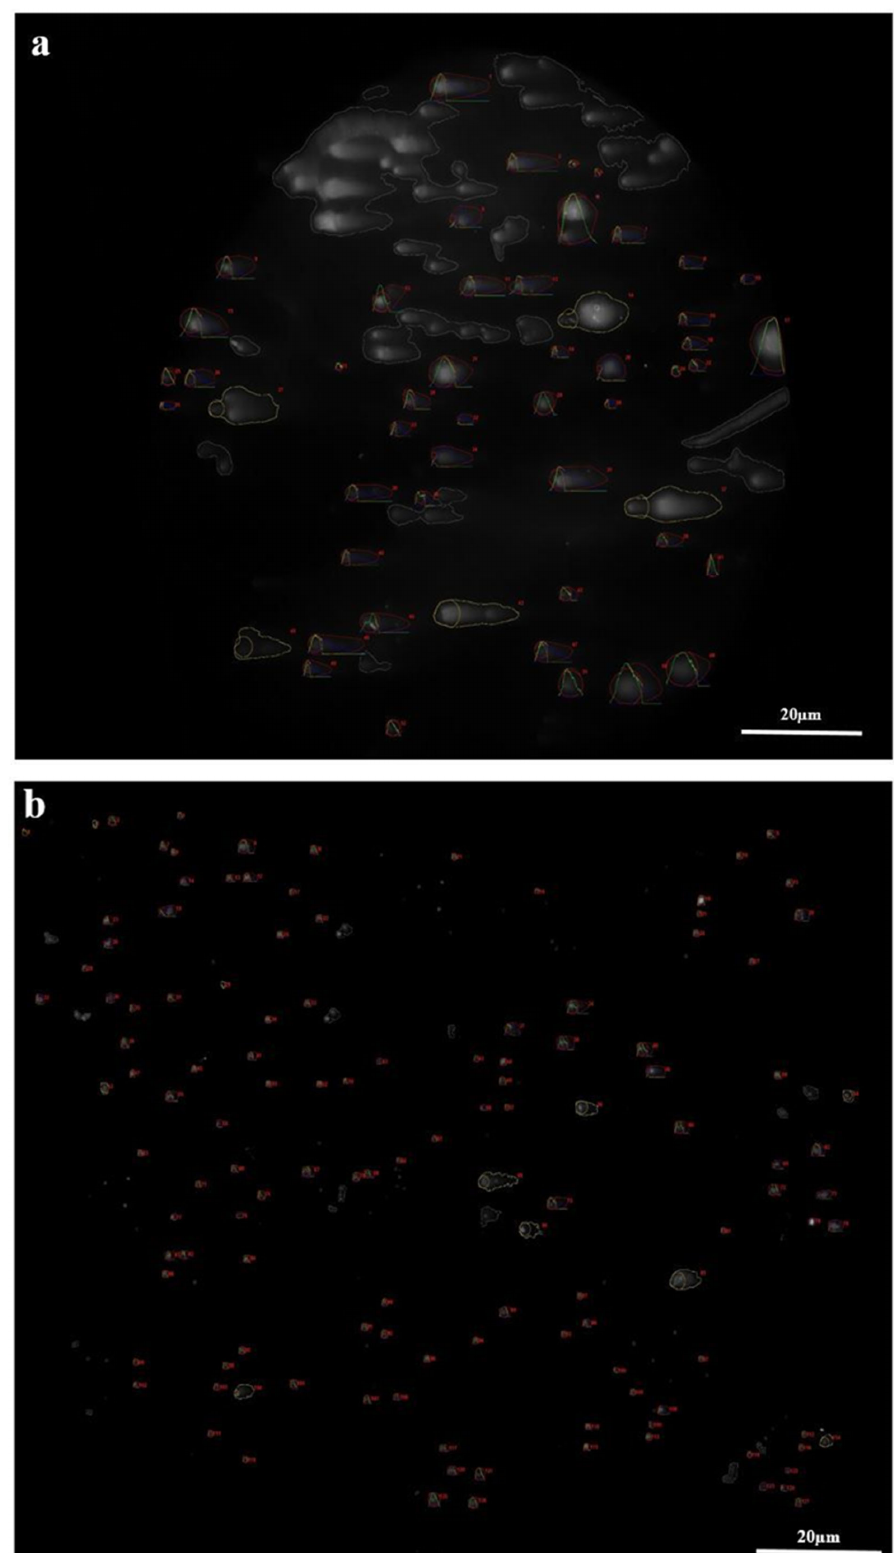
Figure 3. Comet assay distribution of the COVID ‐ 19 and control groups (×1000 magnification). The damaged samples of the COVID ‐ 19 ( a ) and control ( b ) groups.